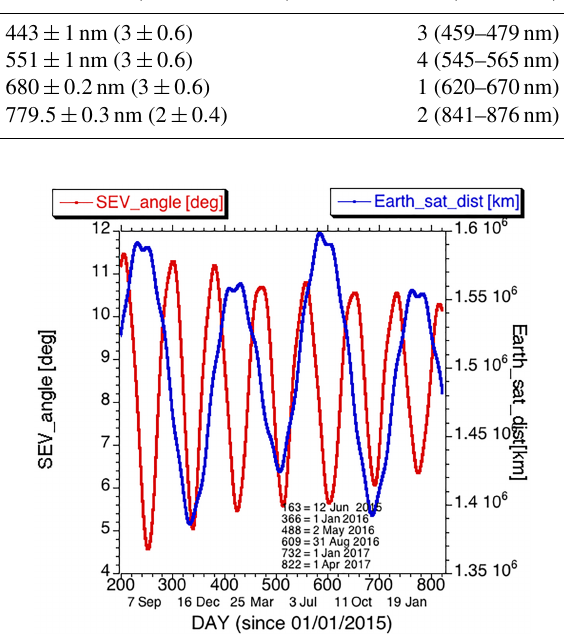
Figure 2. Solar Earth vehicle (SEV) angle (left axis, red curve) and the distance between DSCOVR and Earth (right axis, blue curve) are plotted versus the day since 1 January 2015. Note that SEV = 180 ◦ – scattering angle between solar and viewing direc- tions. Also note that the distance between DSCOVR and Earth changes by approximately 2000–2500km per day.